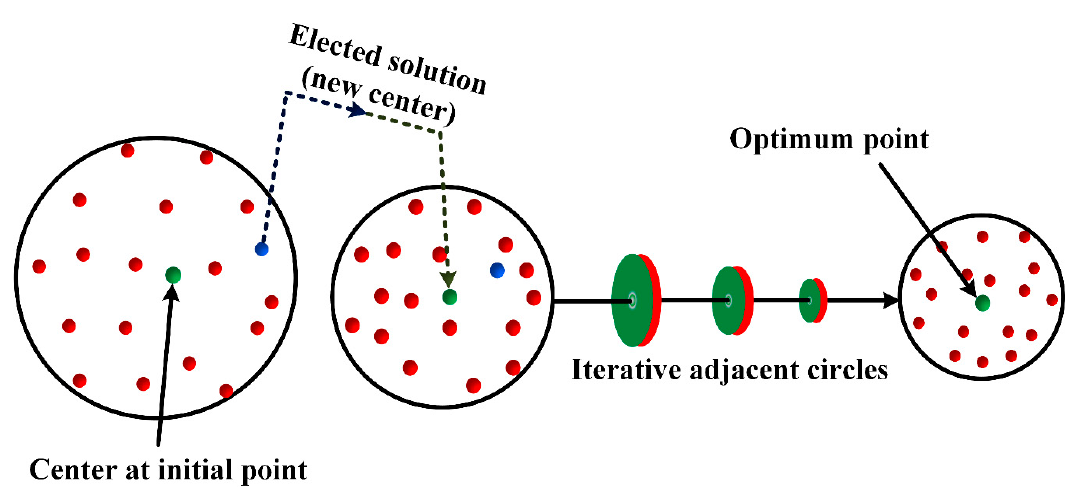
Figure 2. Representation of the working search process using a model of the VS in a two-dimensional nested circle form.